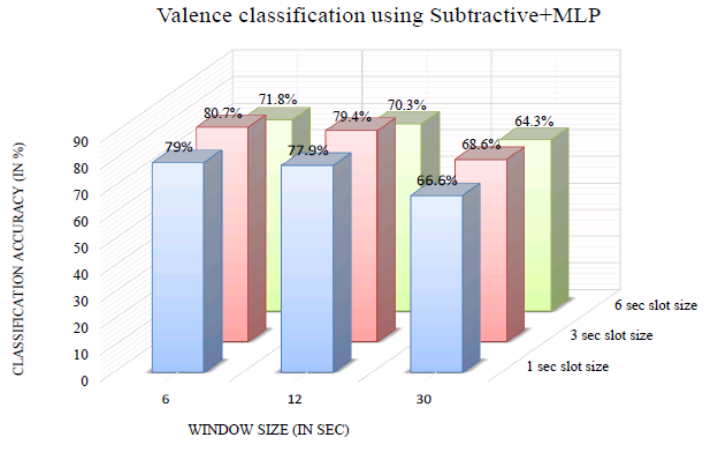
Figure 10. Valence classification accuracy of the subtractive+MLP method for various window